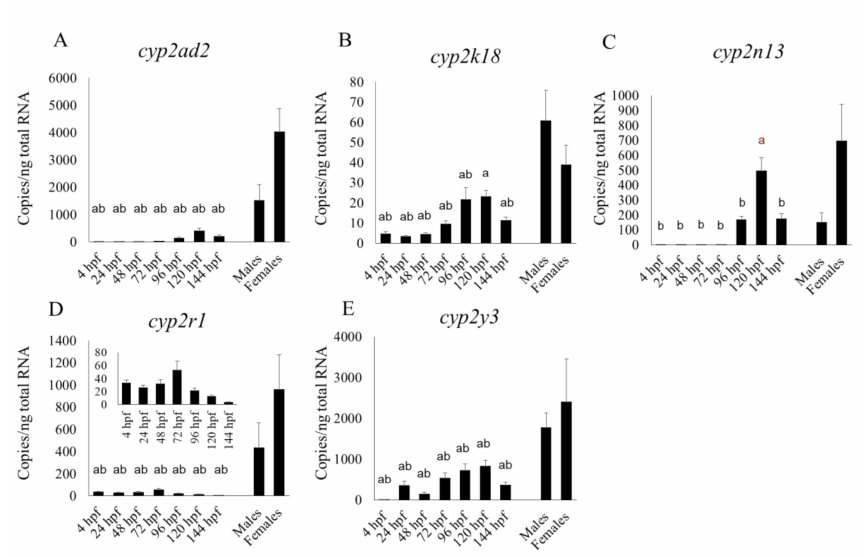
Figure 2. Developmental expression of five mRNA of cyp2 isoforms in zebrafish whole embryos and larvae from 4 to 144 h post-fertilization (hpf) in comparison with their expression in the livers of adults of both sexes. Results of cyp2ad2 ( A ), cyp2k18 ( B ), cyp2n13 ( C ), cyp2r1 ( D ) and cyp2y3 ( E ) are shown. An inset graph was added in embryonic and larval cyp2r1 expressions ( D ). “a” indicates a significant ( p < 0.05) di ff erence compared with male livers and “b” is a significant ( p < 0.05) di ff erence compared with female livers. Black letters indicate significantly lower expression in embryos or larvae compared with adult livers, and red letters indicate significantly higher expression in embryos or larvae compared with adult livers. n = 6.